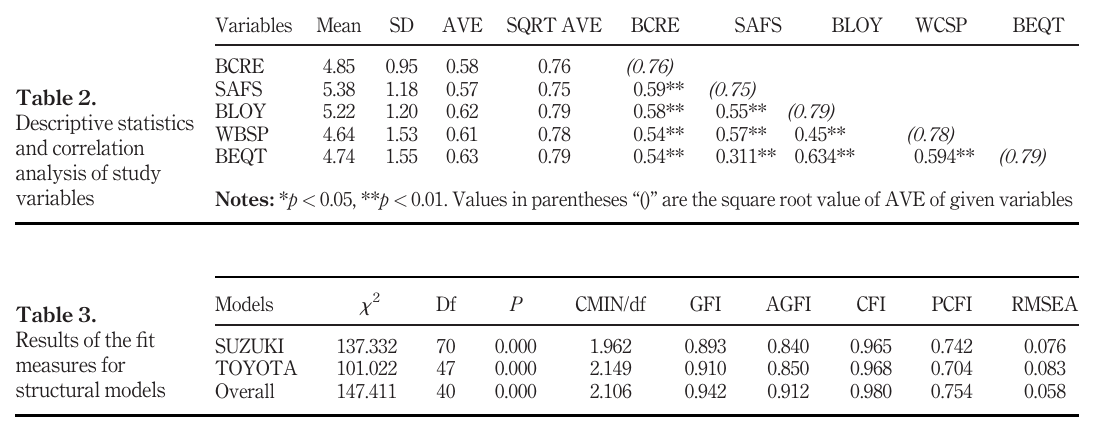
Table 3. Results of the fi t measures for structural models